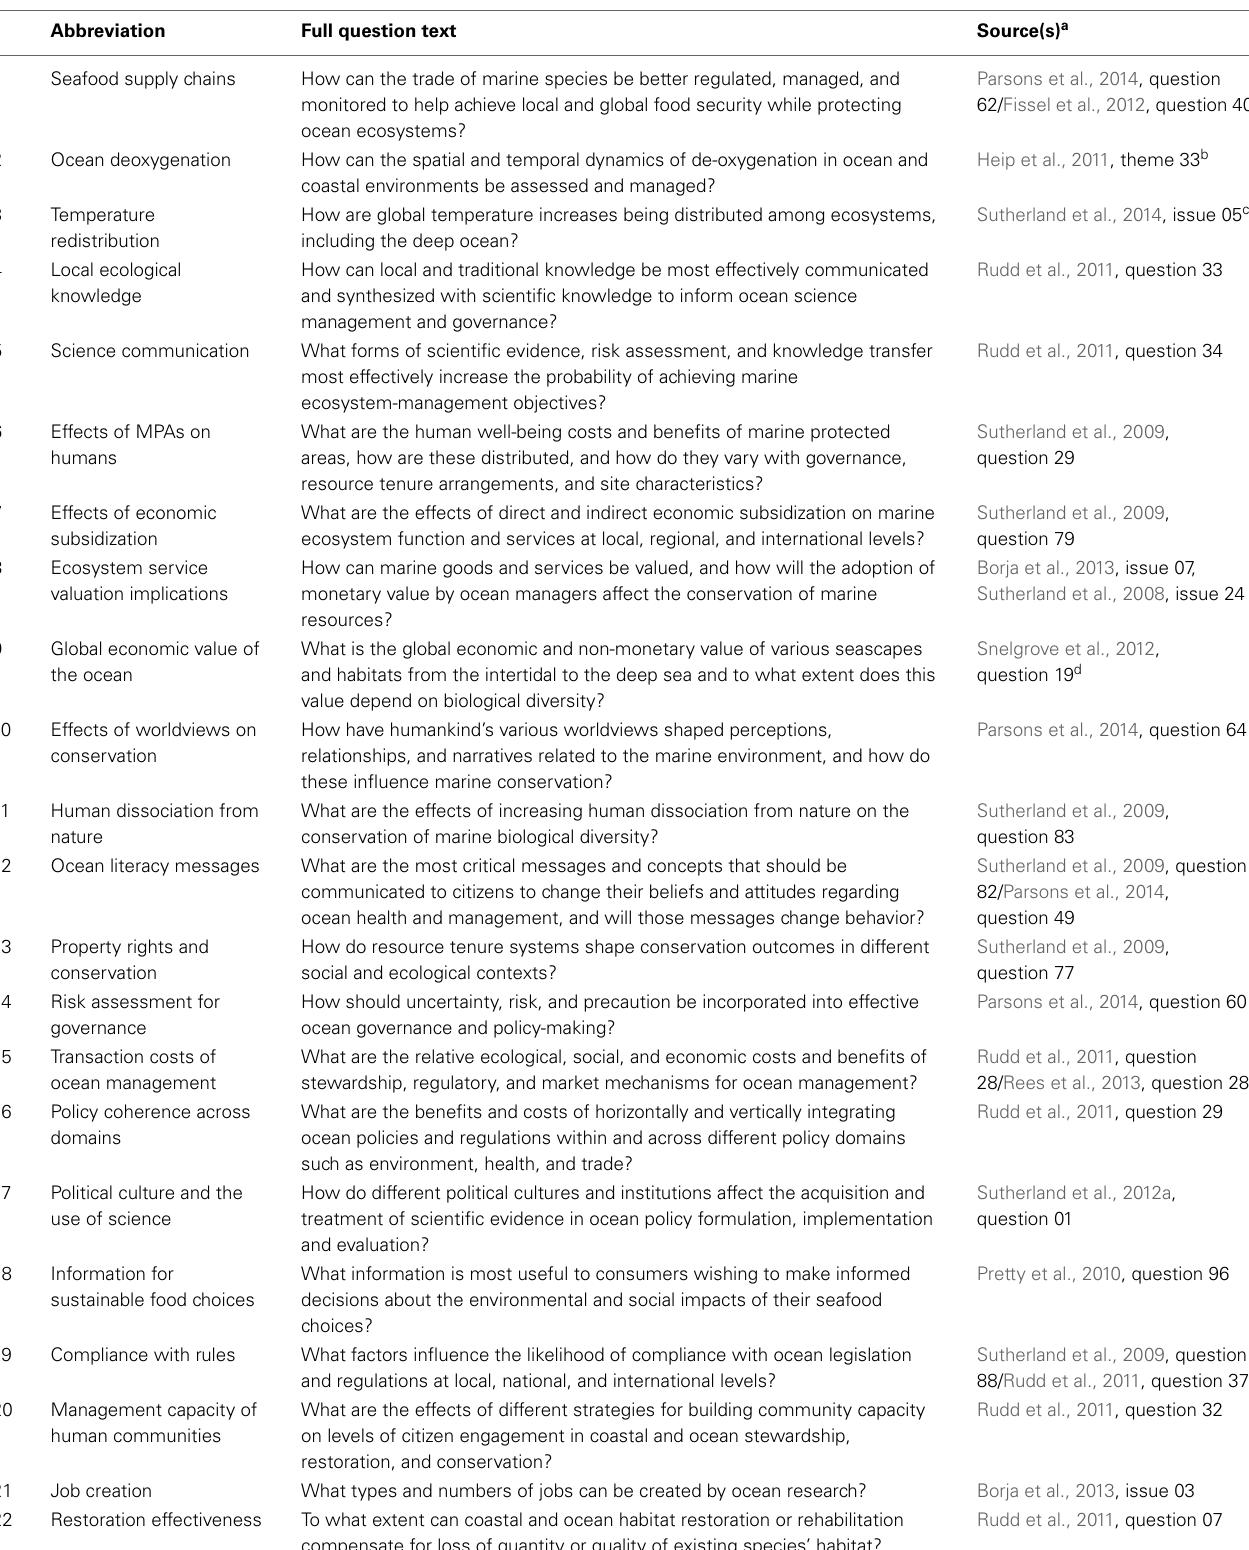
Table 1 | Final list of [unranked] research questions synthesized from 22 research scanning